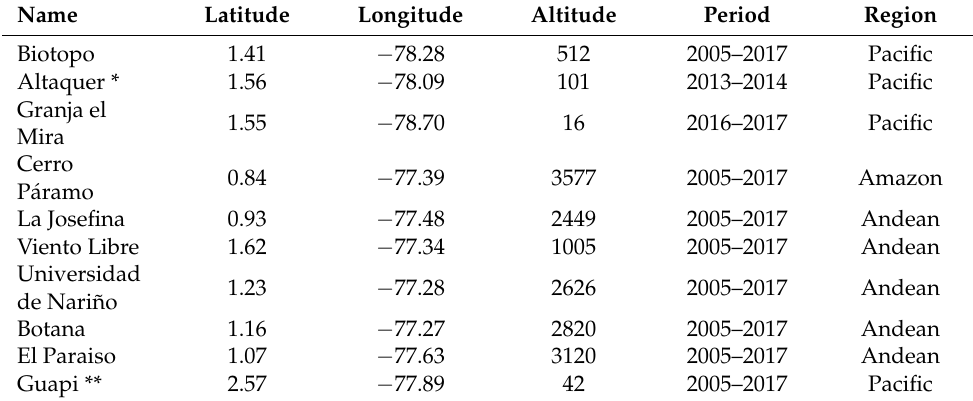
Table 1. Automatic weather stations in Nariño.